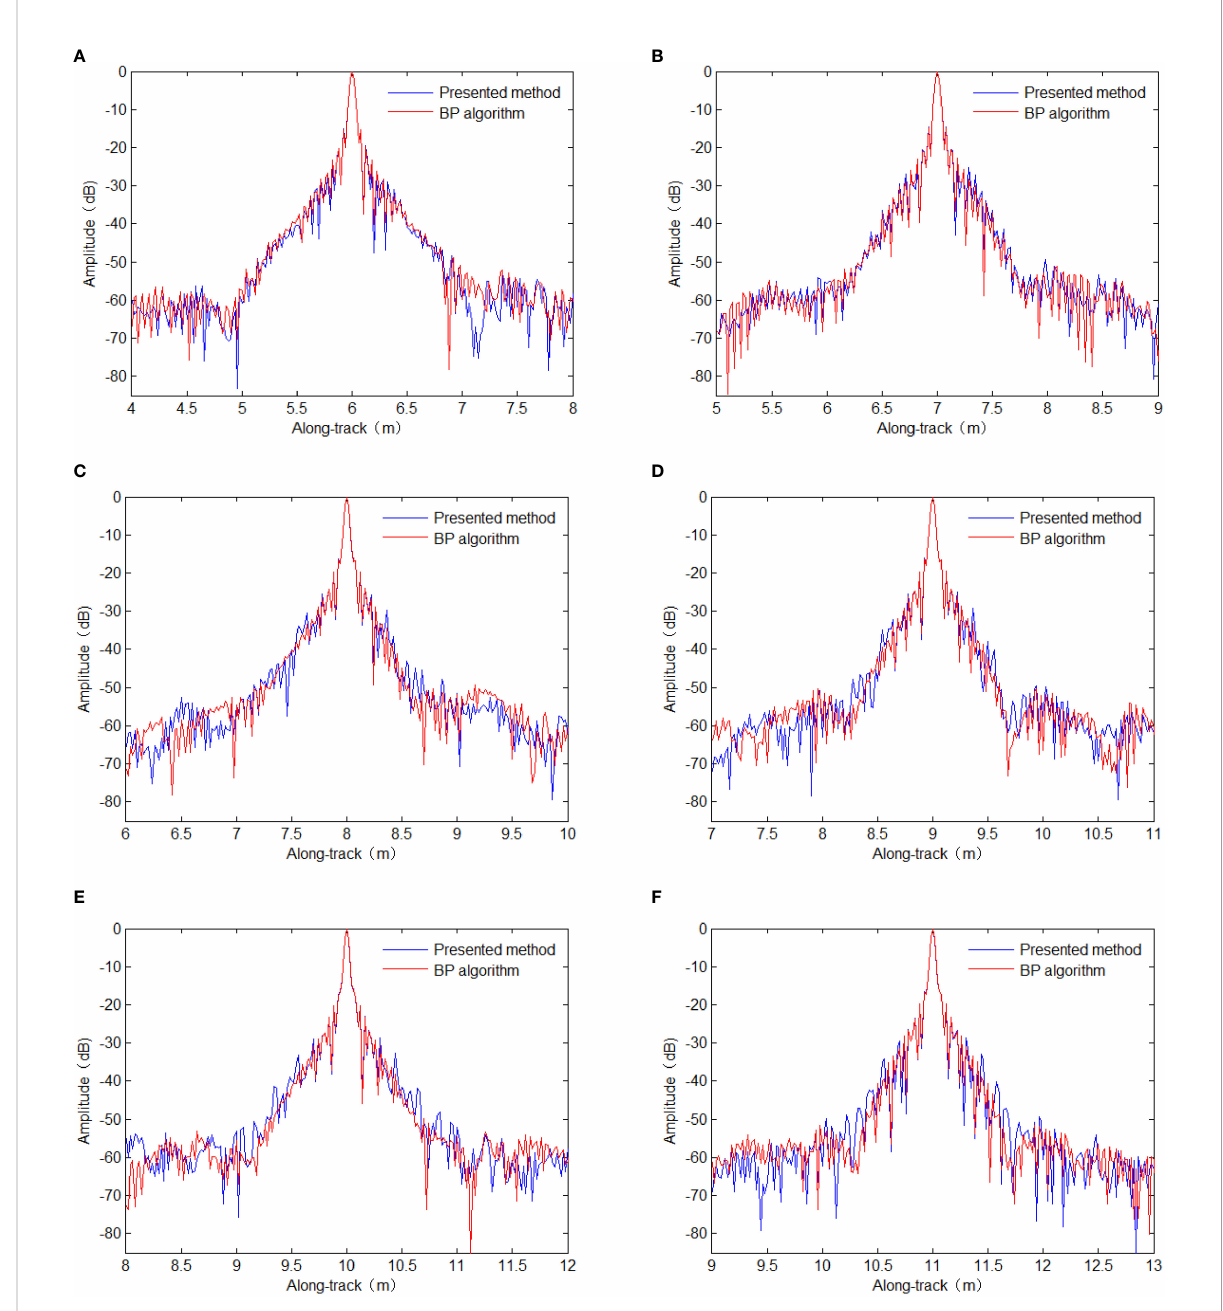
FIGURE 6 Along-track slices of the focused targets. (A) T1. (B) T2. (C) T3. (D) T4. (E) T5. (F) T6. BP ,